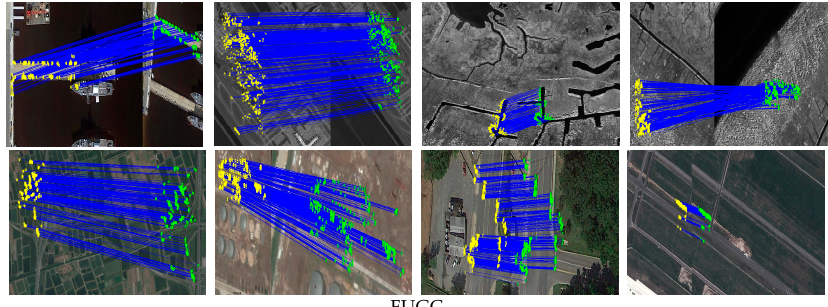
Figure 9. Results for several typical image pairs of the four testing datasets, namely, DOTA, NOAA, RSOD and UCAS, obtained using the RANSAC, VCF, GMS, UGC and FUGC algorithms. The red boxes and red lines on the maps are examples of incorrectly established matches. It is clear that FUGC performs better in both matching precision and the number of final matches.